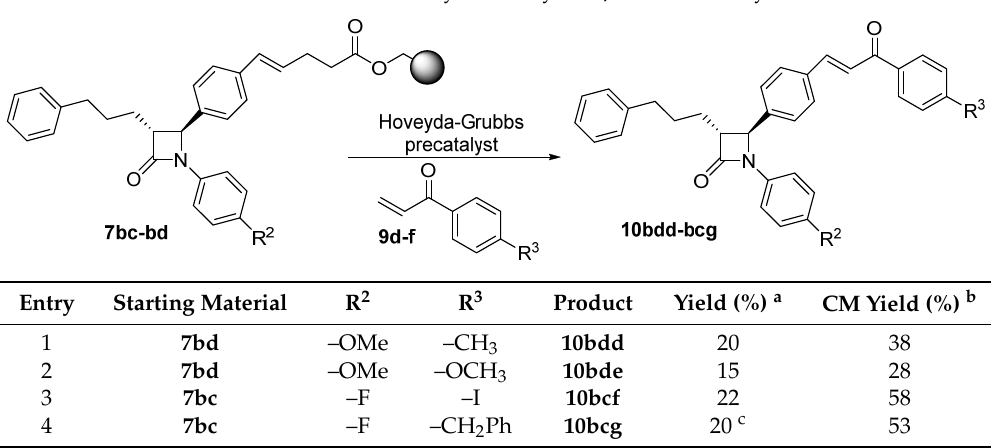
Table 3. The secondary “Ru2” hybrid β –lactam library.